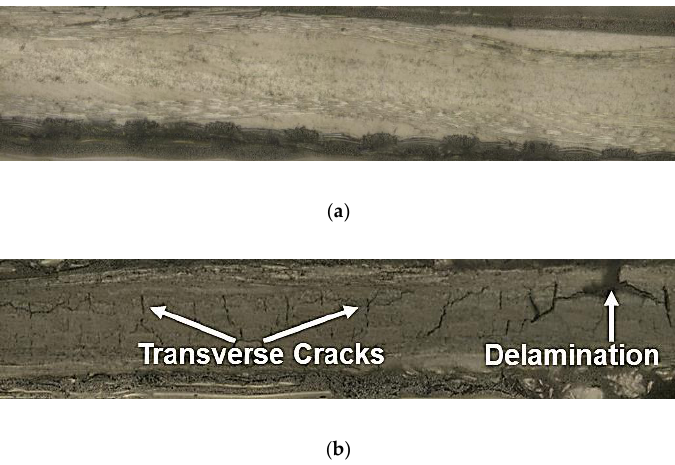
Figure 11. Micrographs showing damage states at varying loads ( a ) within the elastic region, no microcracks formed and ( b ) just before failure, transverse cracks and delamination can be observed.